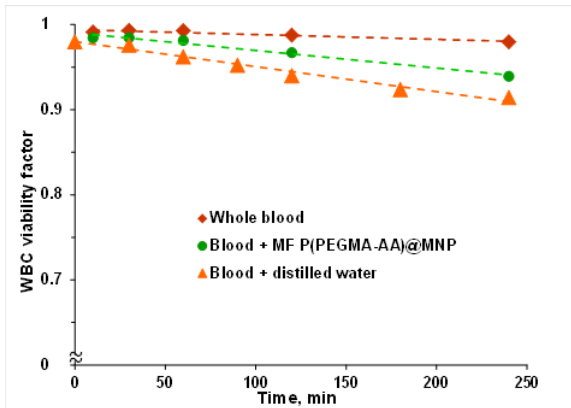
Figure 9. Changes in white blood cell viability factor as a function of time in whole blood and blood diluted with magnetic fluid (the P(PEGMA)@MNP concentration in blood is 0.4 mg/mL) and distilled water.